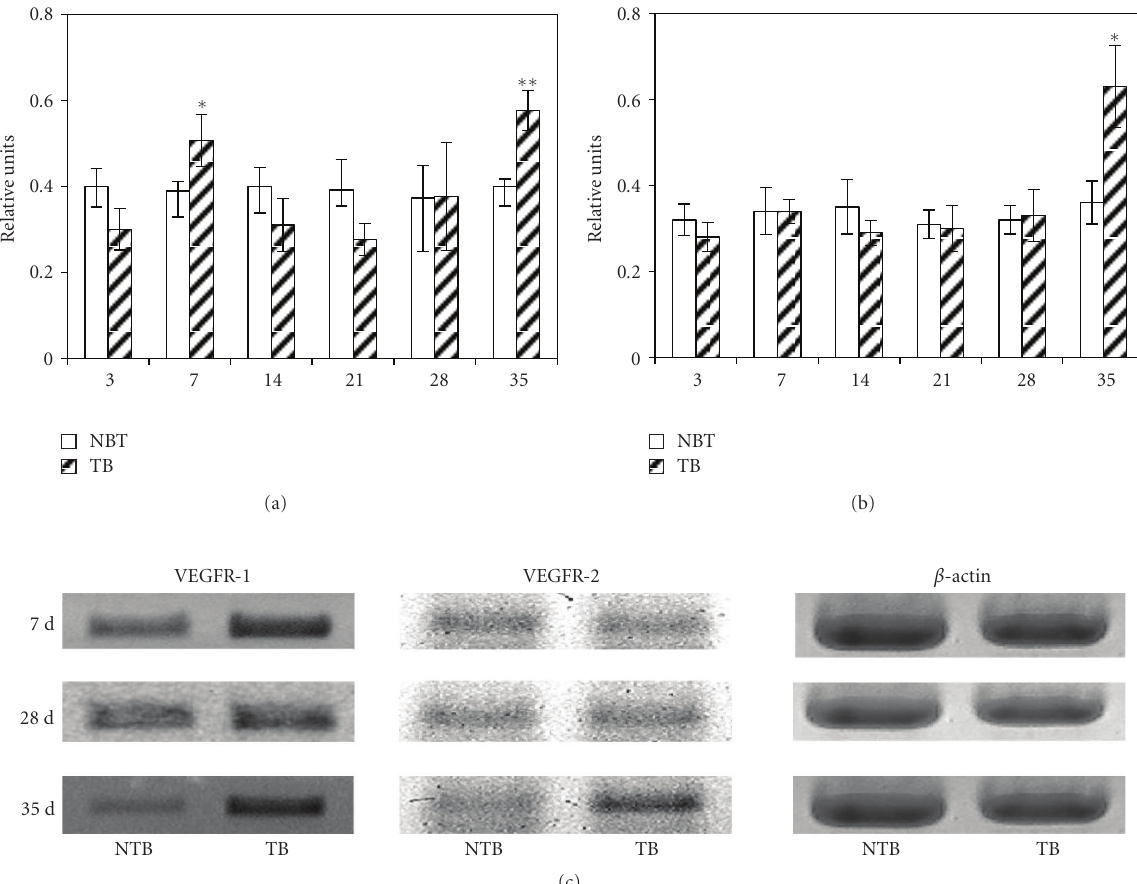
Figure 2: Hepatoma growth increases VEGFR-1 (a) and VEGFR-2 mRNA expression (b) in peritoneal macrophages. Total RNA was isolated from peritoneal cells from each mouse individually. Two μ g of total RNA were used to perform semiquantitative (reverse-transcription) RT- PCR as described; mRNA levels specific for VEGFR-1 and VEGFR-2 were normalized to β -actin. Each bar represents the average obtained from 8 mice (M ± SEM); ∗ P < . 05, ∗∗ P < . 01 compared to control. (c) Representative RT-PCR analysis for VEGFR-1 and VEGFR-2 mRNA expression in macrophages. NTB: nontumor bearing mice; TB: mice with hepatoma 22a.